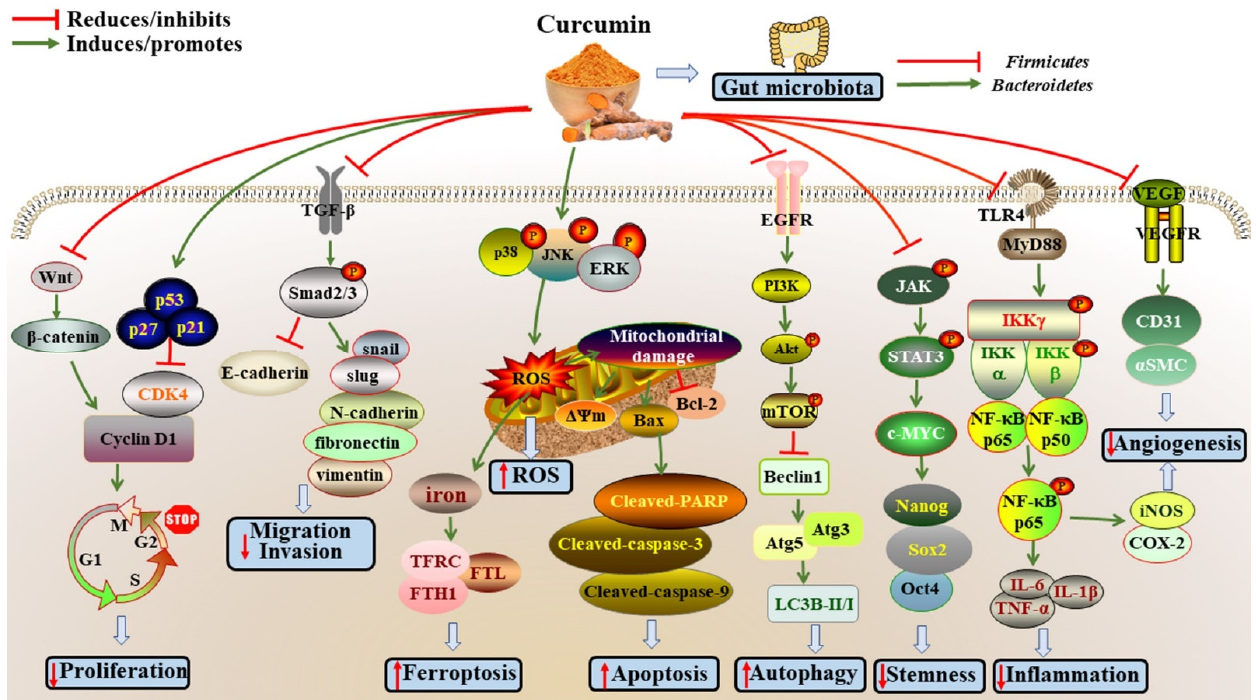
Figure 1. The main effects and mechanisms of curcumin on cancers. (1) Curcumin could suppress proliferation by attenuating cell cycle via inhibiting Wnt/β-catenin pathway, increasing the levels of p53, p21 and p27, and then inhibiting the levels of CDK4 and Cyclin D1. (2) Curcumin could enhance the levels of E-cadherin and decrease the levels of N-cadherin, vimentin, fibronectin, slug and snail through suppressing TGF-β/Smad2/3 pathway, ultimately inhibiting migration and invasion. (3) Curcumin could stimulate ROS production by activating p38 MAPK, JNK and ERK pathways. (4) Curcumin could trigger ferroptosis, and increase the levels of TFRC, FTL and FTH1. (5) Curcumin could promote apoptosis by enhancing the expression of apoptotic proteins (Bax, Cleaved-caspase- 3, Cleaved-caspase-9 and Cleaved-PARP), and inhibiting the expression of anti-apoptotic proteins (Bcl-2). (6) Curcumin could enhance the expressions of Beclin1, Atg5, Atg3 and LC3B-II/I to promote autophagy by PI3K/Akt/mTOR pathway. (7) Curcumin could reduce the levels of Oct4, Sox2 and Nanog to suppress stemness through inhibiting JAK/STAT3 pathways. (8) Curcumin could sup- press TLR4/NF-κB signaling pathway to attenuate inflammation (TNF-α, IL-6 and IL-1β). (9) Cur- cumin could attenuate angiogenesis by inhibiting the expressions of VEGF, CD31, αSMC, iNOS and COX-2. (10) Curcumin could regulate gut microbiota by reducing the ratio of Firmicutes/Bacteroidetes. Abbreviations: Akt, protein kinase B; Atg3, autophagy related 3; Atg5, autophagy related 5; Bax, Bcl-2 associated X protein; Bcl-2, B-cell lymphoma-2; Caspase-3, cysteinyl aspartate specific protein- ase 3; Caspase-9, cysteinyl aspartate specific proteinase 9; CDK4, cyclin dependent kinase 4; EGFR, phospho-epidermal growth factor receptor; ERK, extracellular regulated protein kinases; FTH1, fer- ritin heavy chain 1; FTL, ferritin light chain; G1, where cells decide to grow and divide or enter the G0 phase (enter quiescence); G2, preparation for mitosis; JAK, Janus kinase; JNK, c-Jun N-terminal kinase; IKK, inhibitor of nuclear factor kappa-B kinase; IL-1β, interleukin-1β; IL-6, interleukin-6; IL- 1β, interleukin-1β; LC3, microtubule-associated protein light chain 3; M, mitosis; mTOR, mamma- lian target of rapamycin; MyD88, myeloid differentiation primary response 88; NF-κB, nuclear fac- tor kappa-B; Oct4, Octamer-binding transcription factor 4; p38 MAPK, p38 mitogen-activated pro- tein kinase; PARP, poly (ADP-ribose) polymerase; PI3K, phosphatidylinositol-3-kinase; ROS, reac- tive oxygen species; S, DNA synthesis; Smad2/3, SMAD family member 2/3; Sox2, Sex determining region Y-box 2; TFRC, transferrin receptor; STAT, signal transducer and activator of transcription; TGF-β, transforming growth factor beta; TLR4, toll-like receptor 4; TNF-α, tumor necrosis factor α; VEGF, vascular endothelial growth factor.